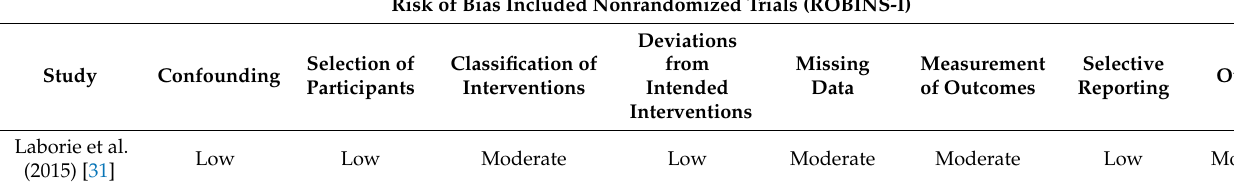
Table 6. Risk of Bias assessment of